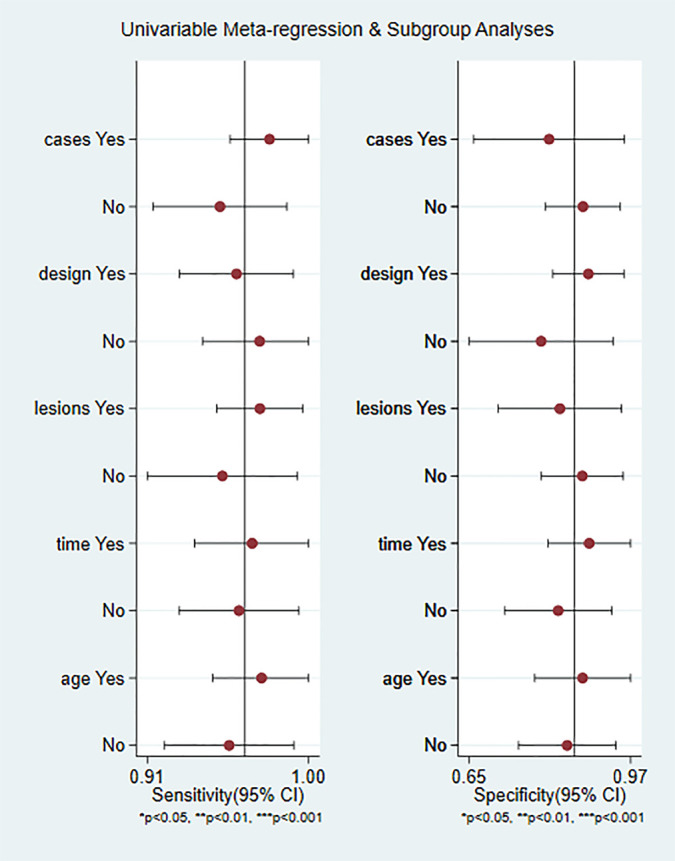
Meta-regression and subgroup analyses of studies.